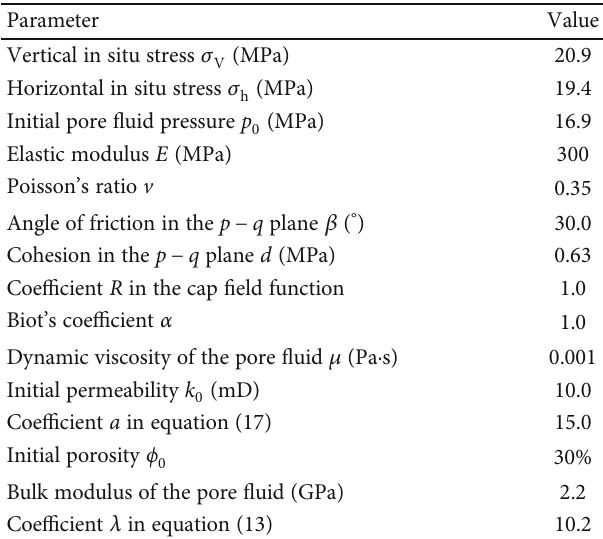
Table 1: Parameters used in the analysis of wellbore stability in deepwater shallow